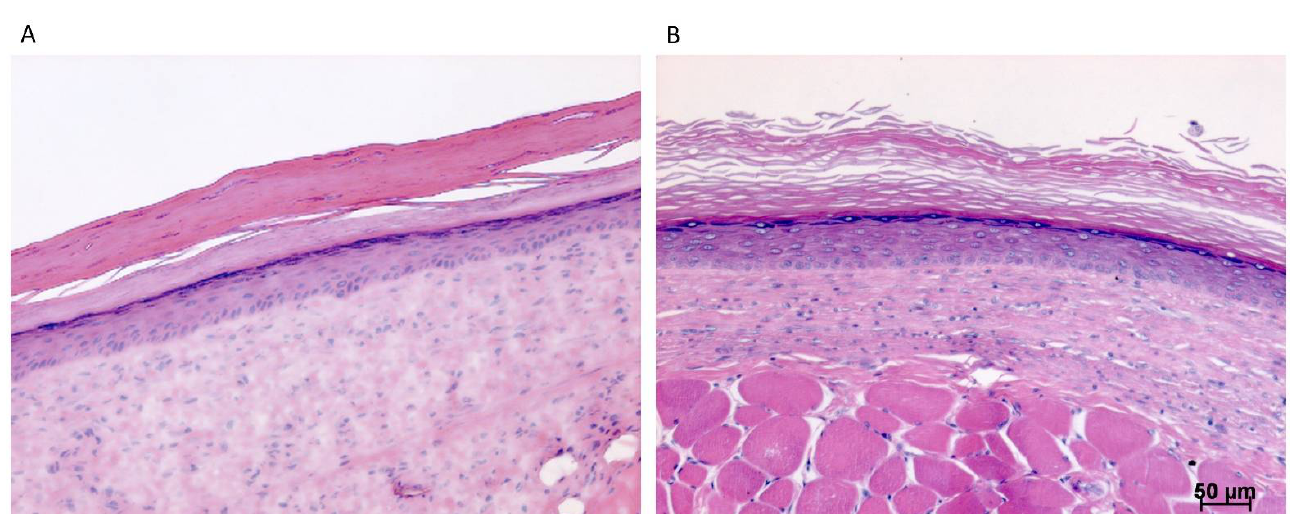
Figure 3. Qualitative assessment of contraction events following surgery . ( A ) Contraction of the graft was assessed over time after grafting. For each mouse, the contraction was evaluated (large, medium, or small to no displacement). Results are presented as the percentage of mice in each cat- egory 7, 14, and 21 days after grafting. ( B ) Representative examples of SASS contraction 14 days after grafting on the back of athymic mice.